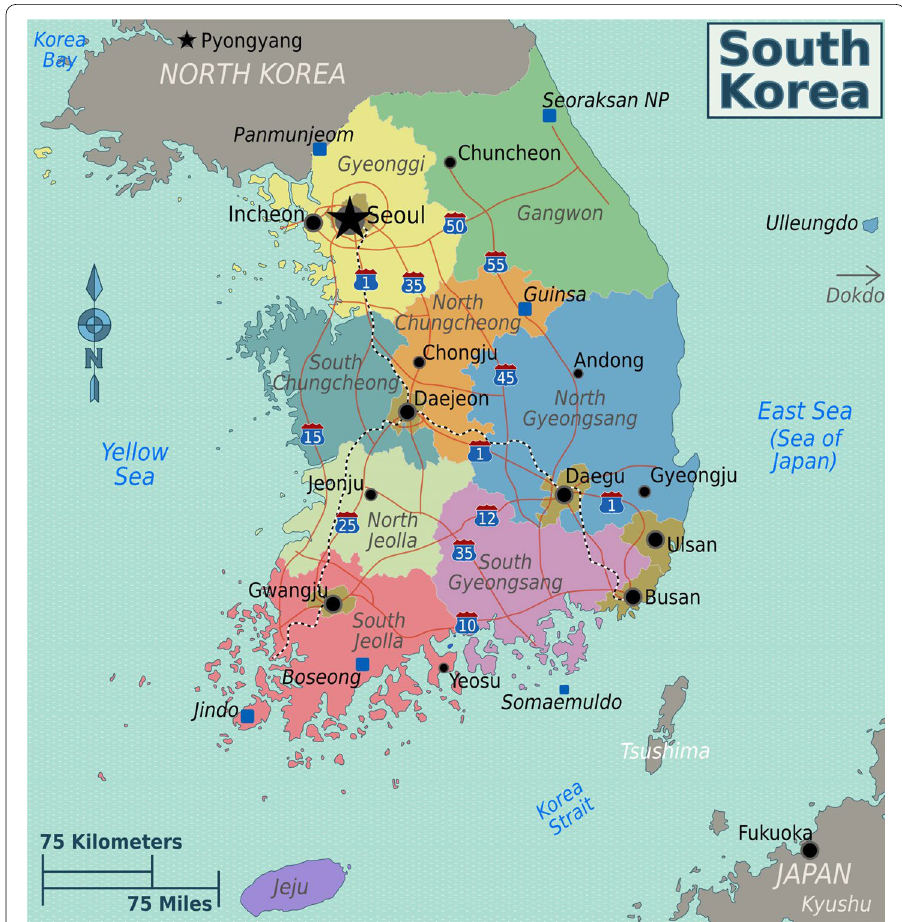
Fig. 1 South Korean regions. Source: South Korea regio ns map merged. png author: Peter Fitzgerald, NordN ordWe st; licensed under the Creative Commons Attribution-Share Alike 3. 0 Unpor ted; available in